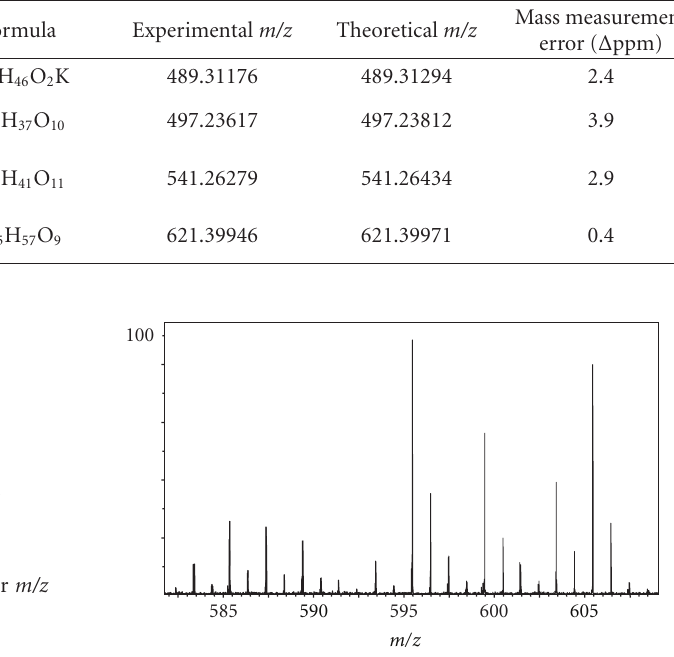
Figure 7: Inset of PS mass spectrum for urine specimen from 27-